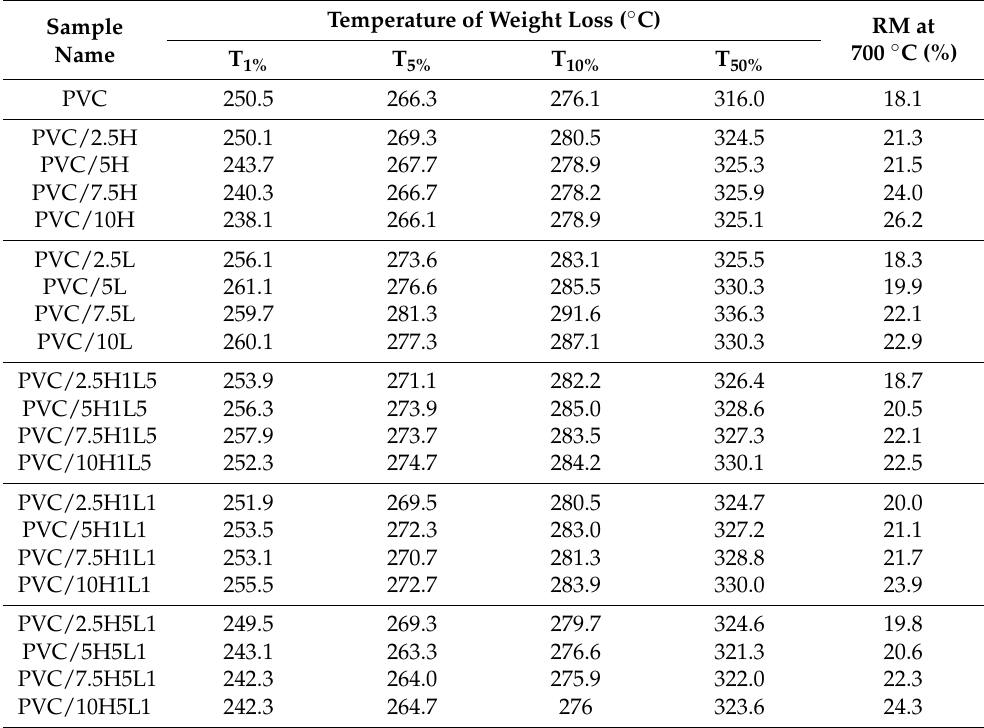
Table 3. TGA analysis results for PVC and PVC